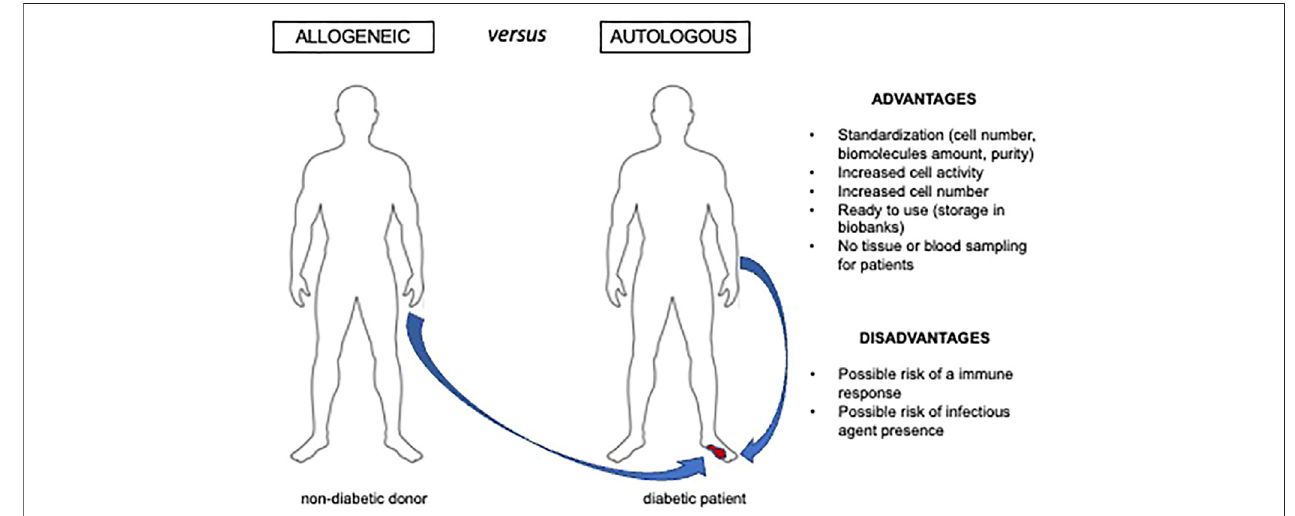
FIGURE 2 | Advantages and disadvantages of allogeneic cell. therapy Allogeneic cells or cell derivatives can be an option for ulcer therapy when harvesting autologouspreparationsabletoreactivatethehealingprocessisnotfeasible.Thisisthecaseofdiabeticand/orelderlyindividualsthatmanifestimpairedcellnumberand